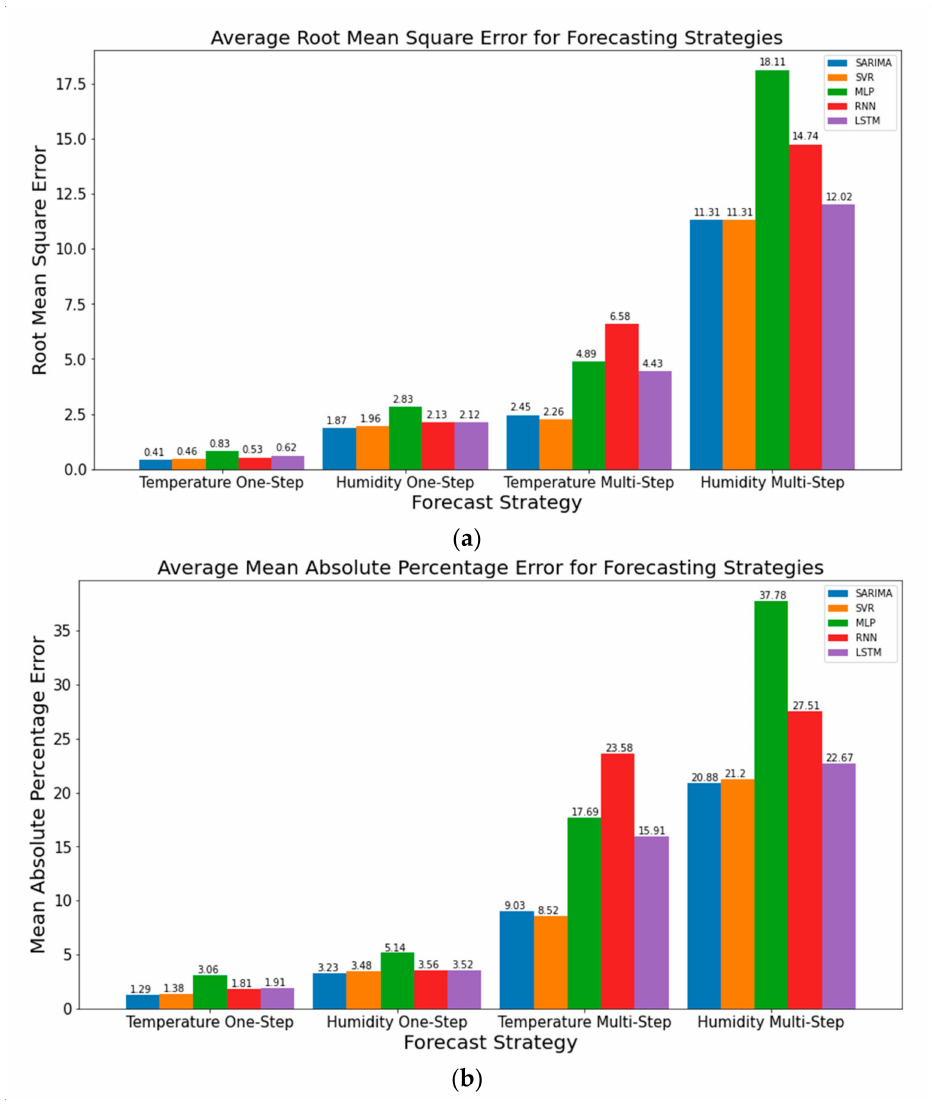
Figure 12. Average performance for forecasting strategies over one-step and multi-step ahead forecasts ( a ) Root Mean Squared Error ( b ) Symmetric Mean Absolute Percentage